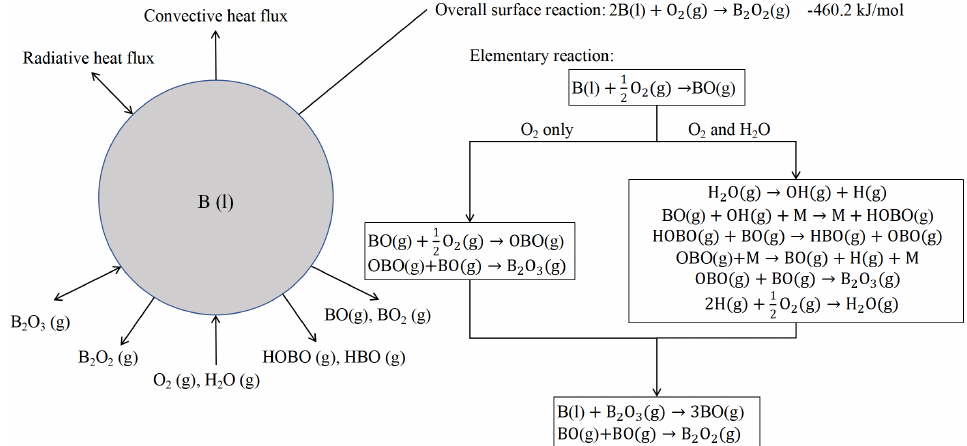
Figure 2. Reaction mechanism of boron particle combustion in the Y - K model [47].